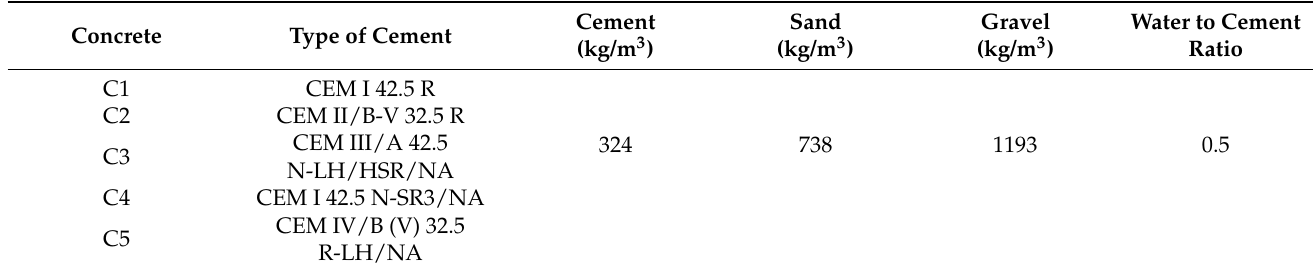
Table 2. The composition of concrete mixtures (data also partially published in